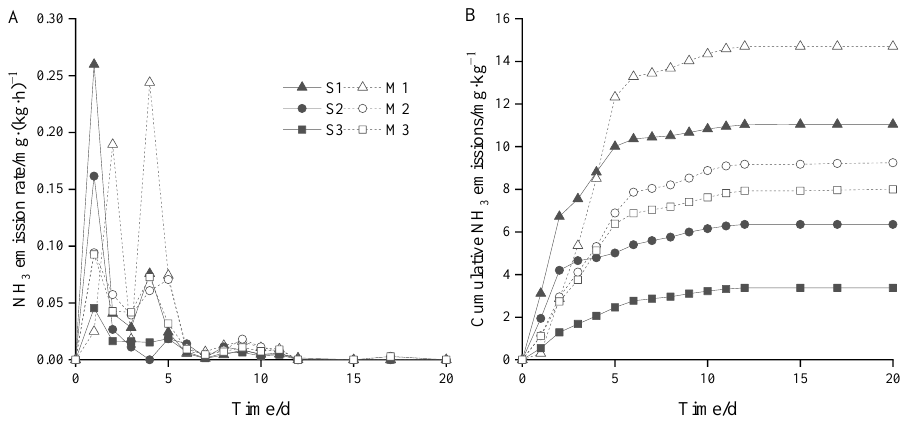
Figure 4. NH 3 emission rate(A) and cumulative NH 3 emissions(B) during composting. S1: pig ma- nure + straw; S2: pig manure + straw + 3% SSP; S3: pig manure + straw + 6% SSP; M1: pig manure; M2: pig manure + 3% SSP; M3: pig manure + 6% SSP.